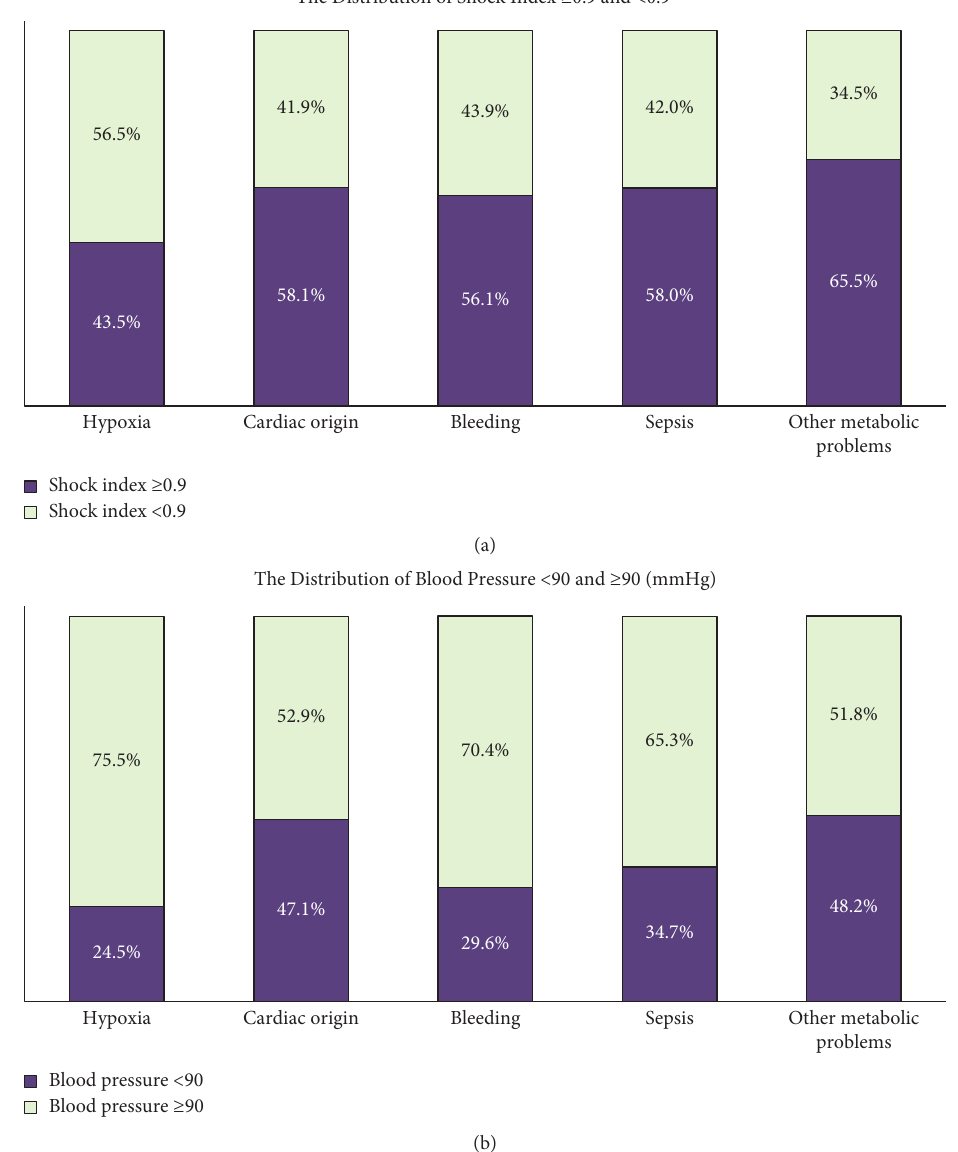
Figure 1: (a) Distribution of shock index ≥ 0.9 and < 0.9 in the five etiologies of cardiac arrest in the emergency department. (b) Distribution of systolic blood pressure < 90mmHg and ≥ 90mmHg in the five etiologies of cardiac arrest in the emergency